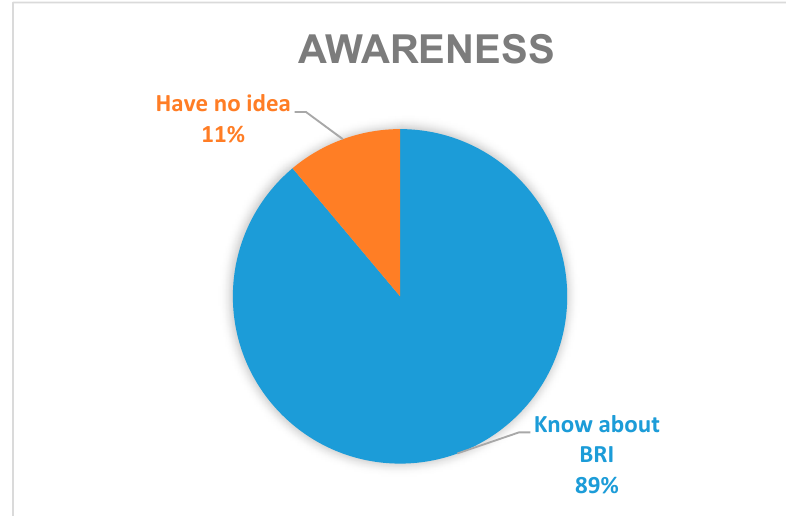
Figure 2. Respondents’ awareness about the Belt and Road Initiative (BRI) (Source: Authors’ analysis).